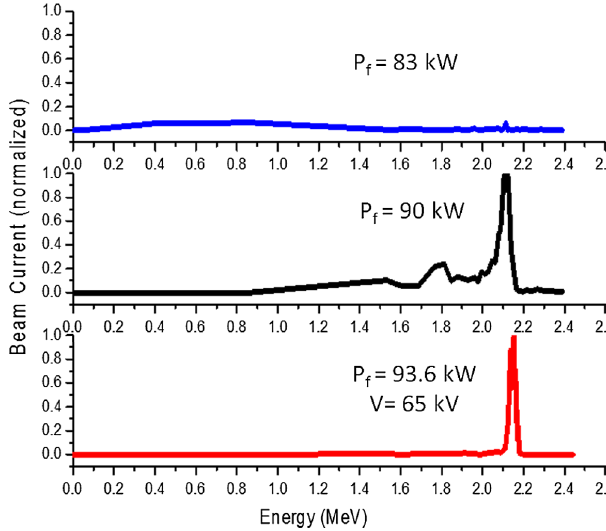
FIG. 10. RFQ beam current versus energy at different input powers.